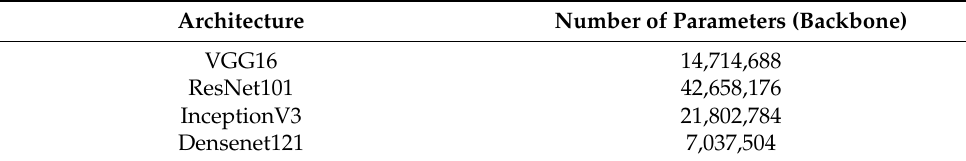
Table 1. Convolutional Neural Network